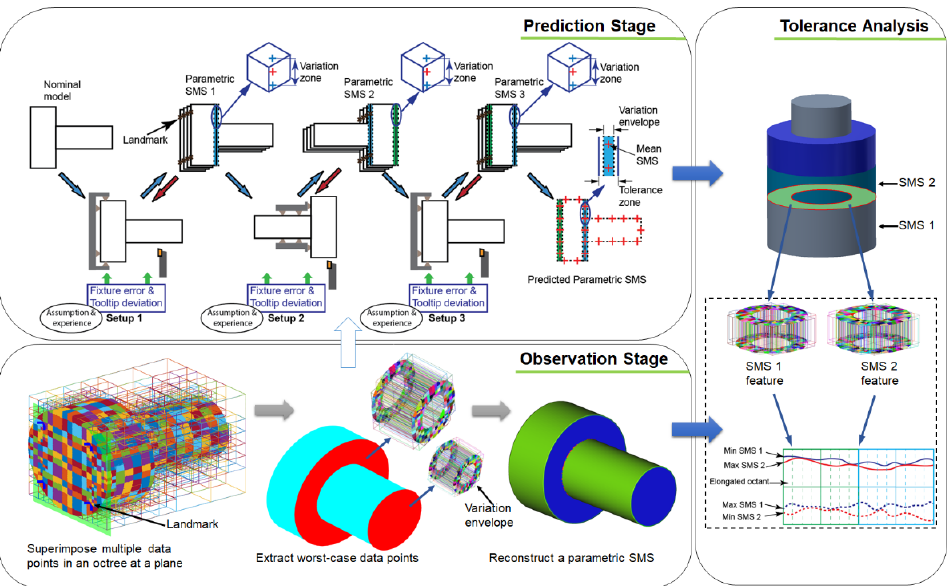
Figure 1. Methodology for generation and variation analysis of Skin Model Shapes (SMSs) with the help of